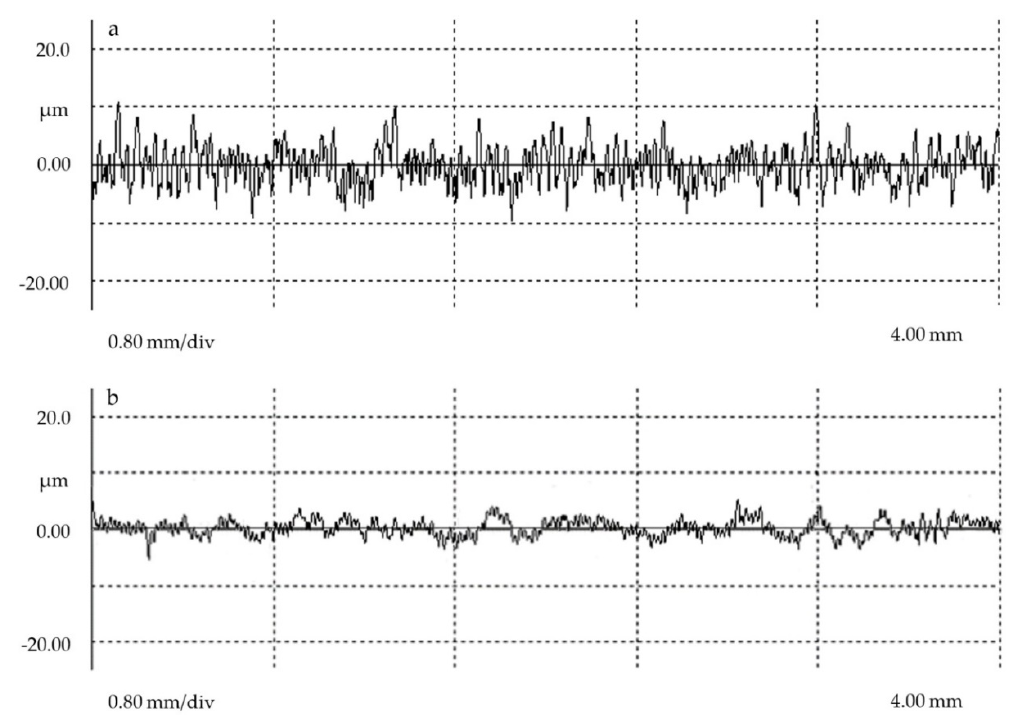
Figure 9. Roughness profiles obtained for: ( a ) 5 W and 10 mm/s; ( b ) 5 W and 250 mm/s.